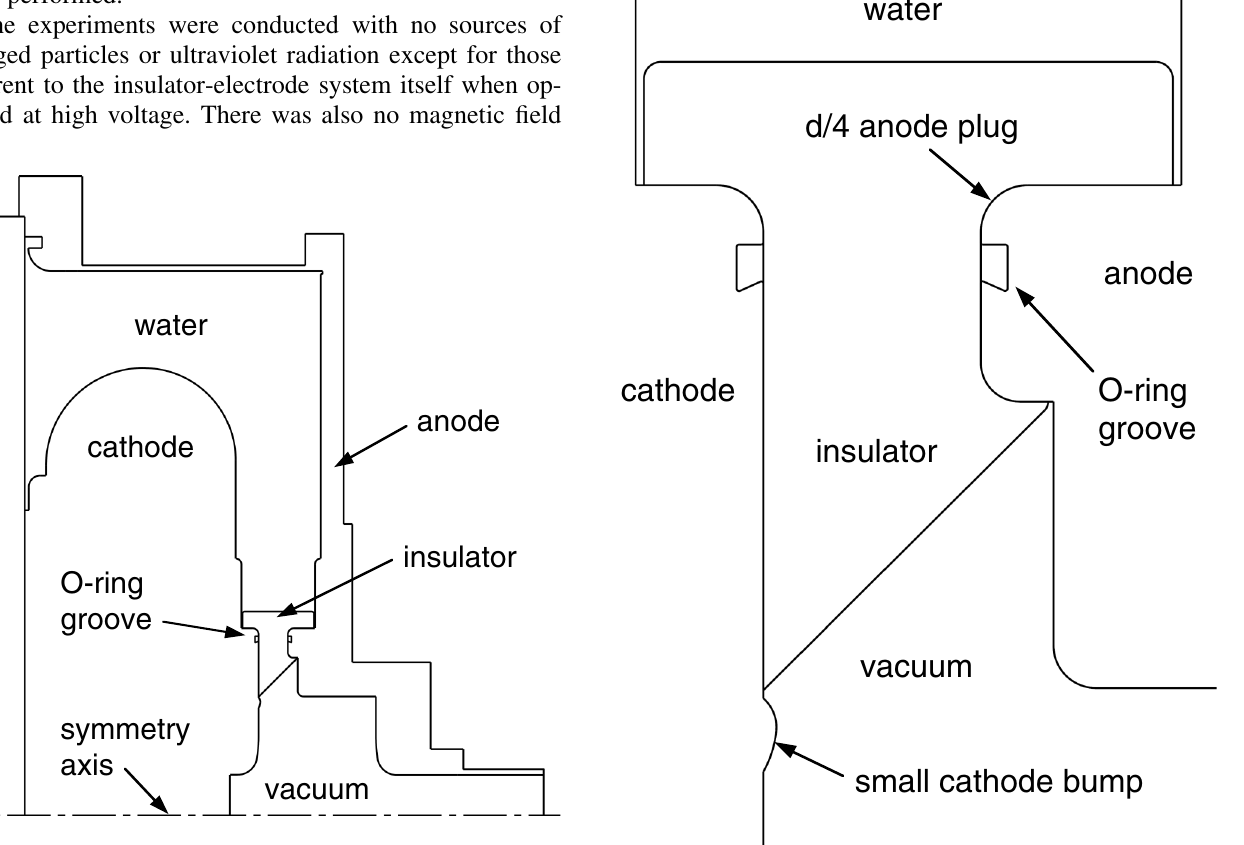
FIG. 11. Detail view of Fig. 10. The insulator-electrode ge- ometry shown is that of configurations F, G, and H.